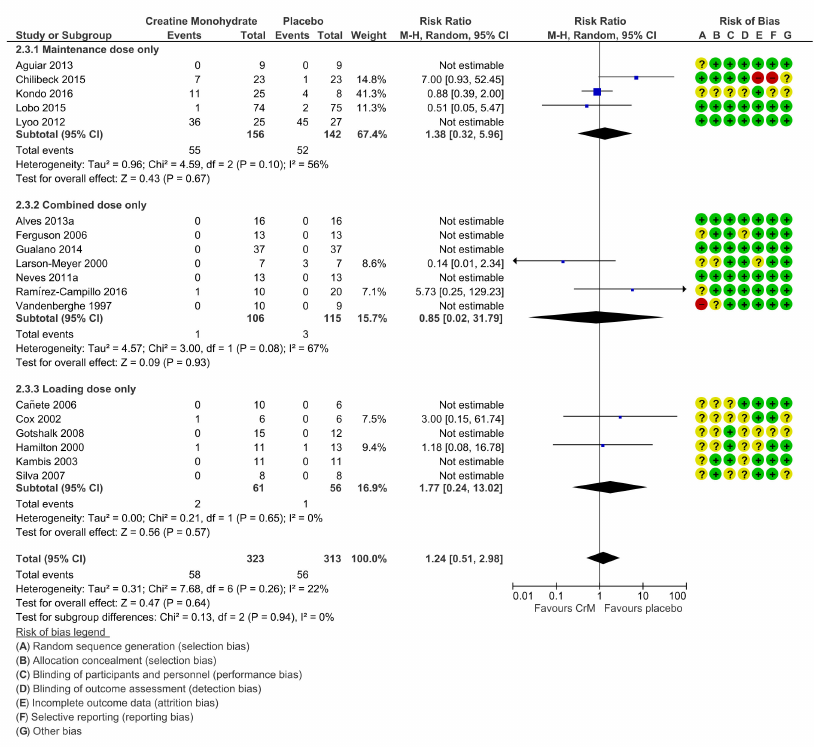
Figure 4. Incidence of adverse events per participant, stratified by dosing regimens. Within Forest Plot, Study or Subgroup = study stratified by dosing regimens; Events = number of adverse events reported; Total = total number of participants in study group; Weight = amount of information contributed by study; M-H = Mantel–Haenszel model; Random = random e ff ects model. Risk of bias; + (green) = low risk of bias, ? (yellow) = unclear risk of bias, - (red) = high risk of